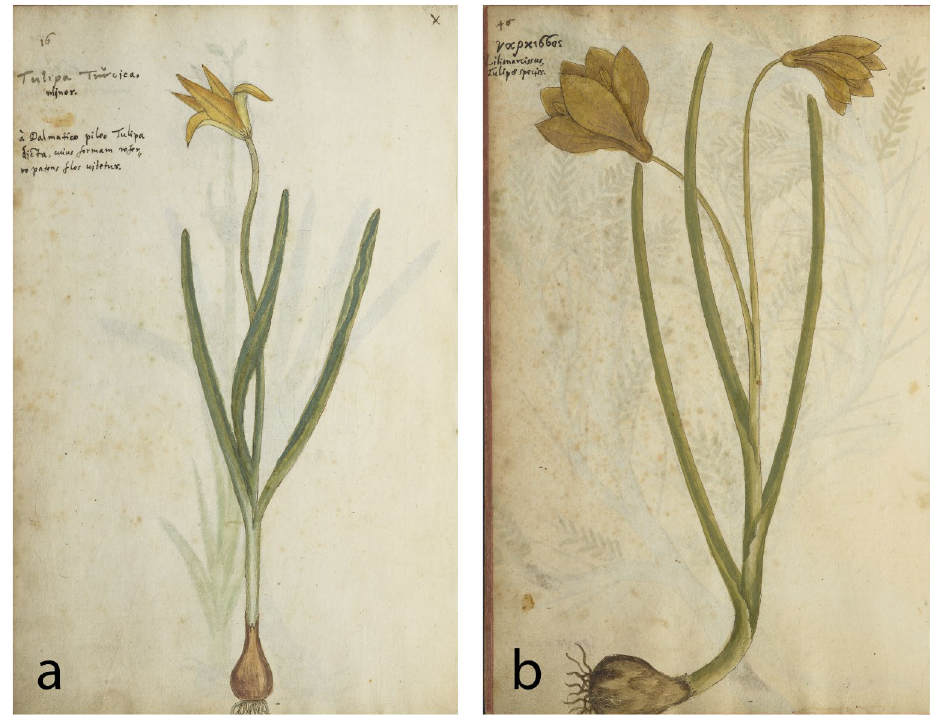
Figure 1. The oldest surviving illustrations of Tulipa sylvestris come from Italy. Codex Kentmanus, 1549. Klassik Stiftung Weimar, 1:16, 40:[16]v ( a ), 2:46, 172:[82]v ( b ).